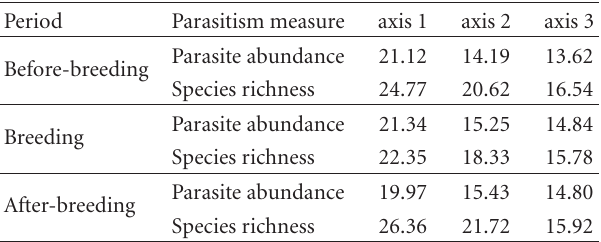
Table 4: The axes of PCA explaining the total variability in the date